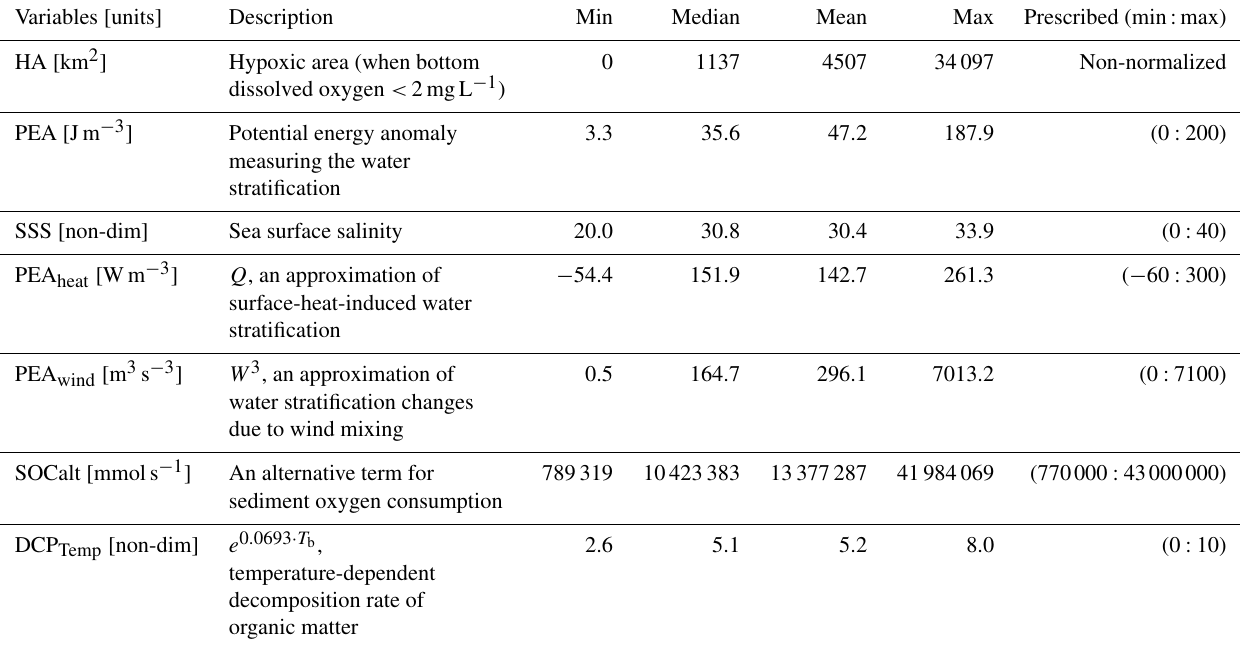
Table 1. Description of daily response variable and candidate predictors. The data cover a time range from 1 January 2007 to 26 August 2020. Prescribed min and max values are used for min–max